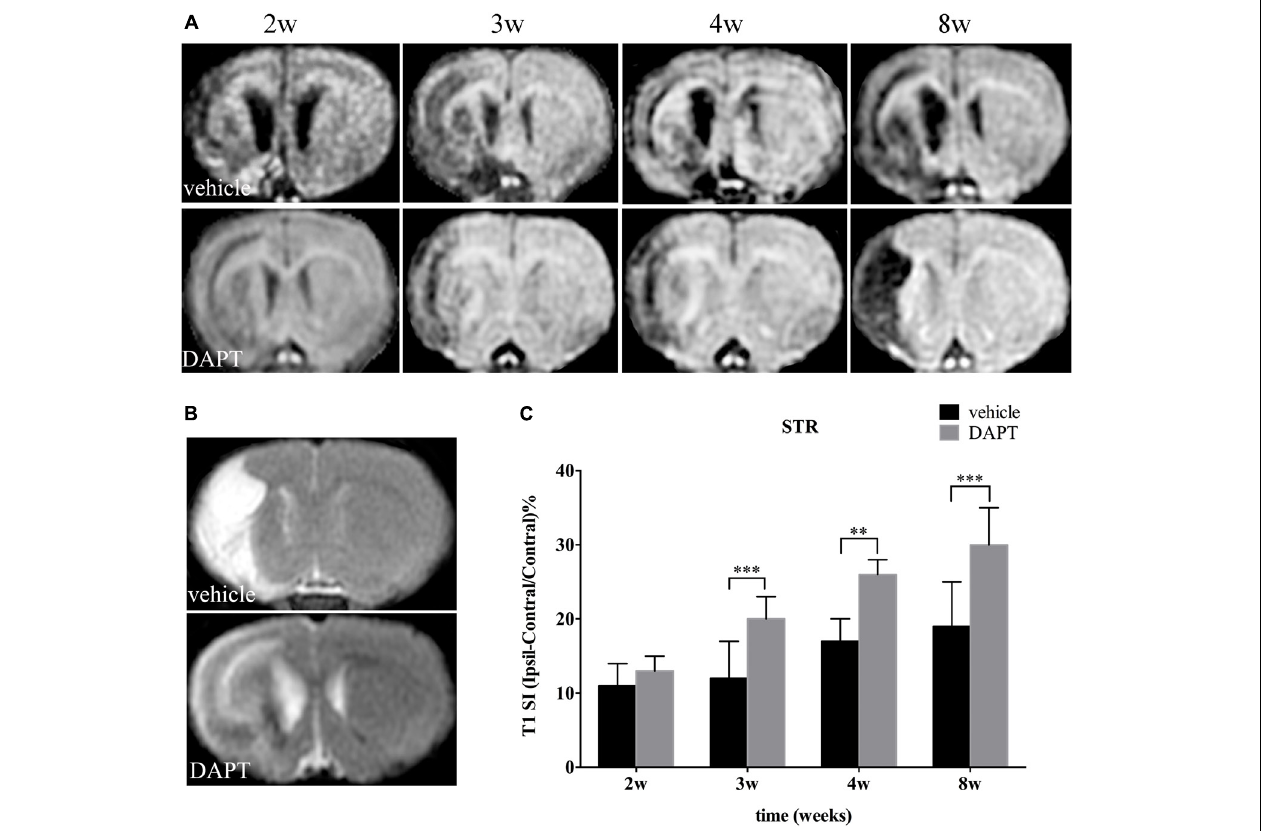
FIGURE 4 | Effects of DAPT on structure changes of STR with T1 MRI after MCAO. (A) The evolution changes in T1 MR images in DAPT-treated rats and vehicle rats from 2 to 8 w. (B) T2 MR images of DAPT-treated rats and vehicle rats at 8 w. (C) Comparison of T1 signal intensity of ischemic boundary between two group rats. ∗∗∗ P < 0.001, 3 w; ∗∗ P < 0.01, 4 w; ∗∗∗ P < 0.001, 8w versus DAPT and